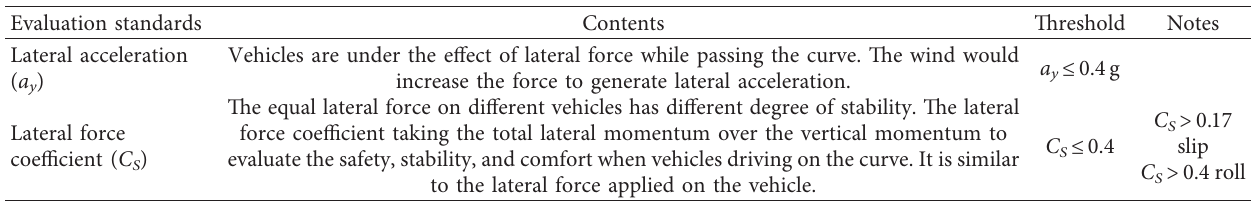
Table 3: Evaluation standards.